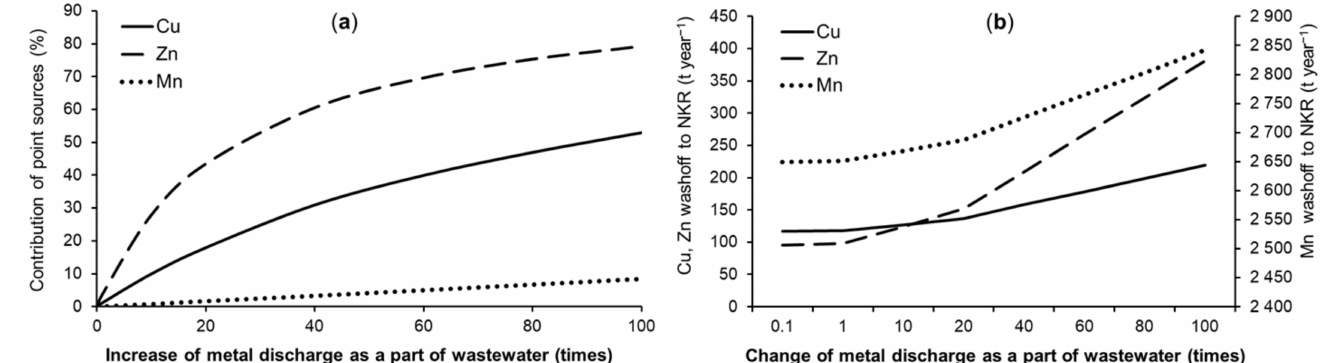
Figure 10. Simulated anthropogenic impact on the NKR basin with changes in the metal content in the wastewater: ( a ) Contribution of point sources to the river water pollution, ( b ) wash-off of metals to the NKR.